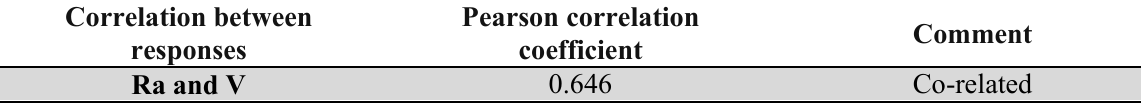
Correlation checking